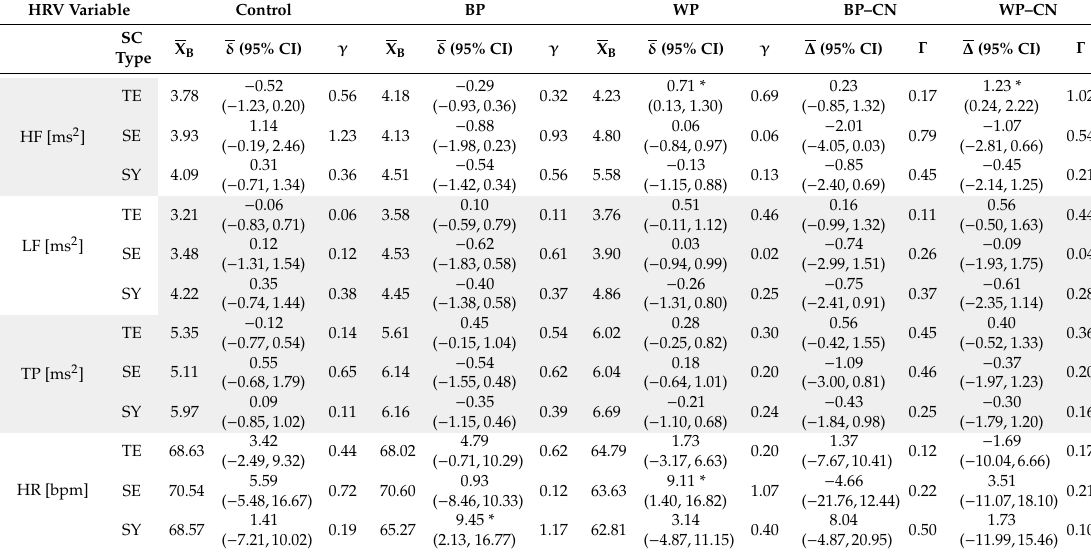
Table A3. Changes in HRV variables after FTPs according to SC types (ANCOVA results). The details are identical to those in Table